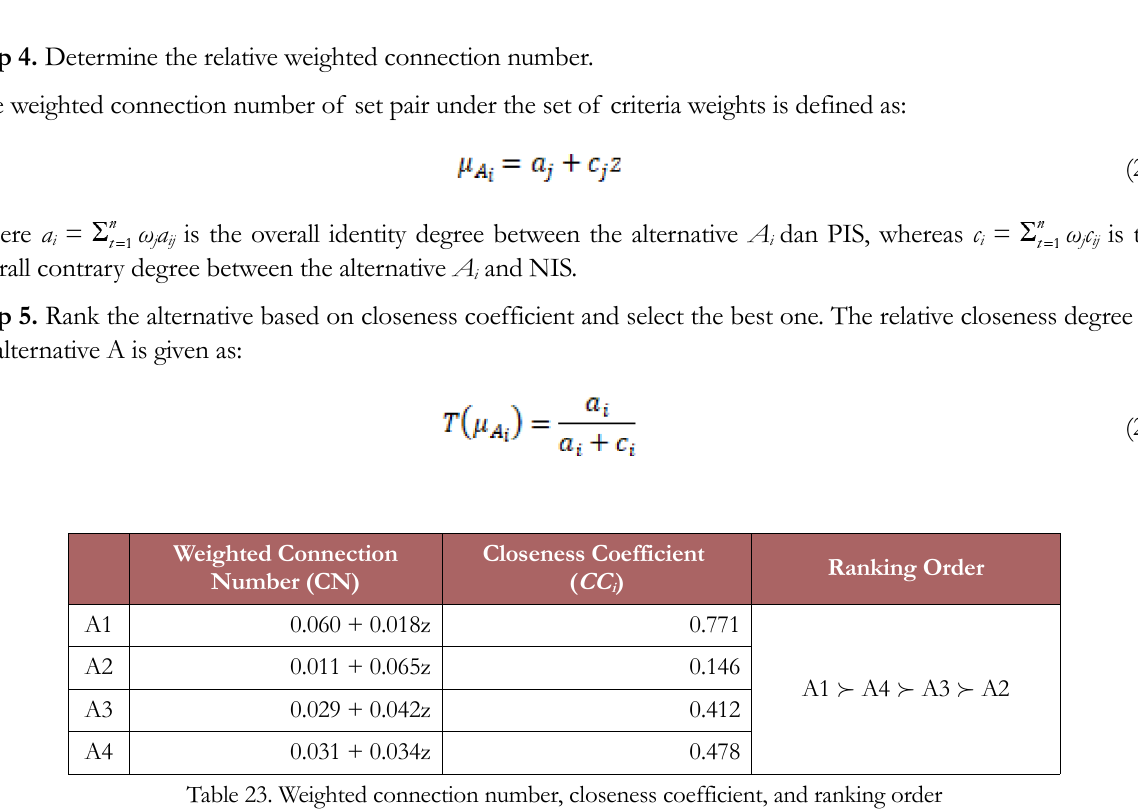
Table 22. Connection number of each alternative